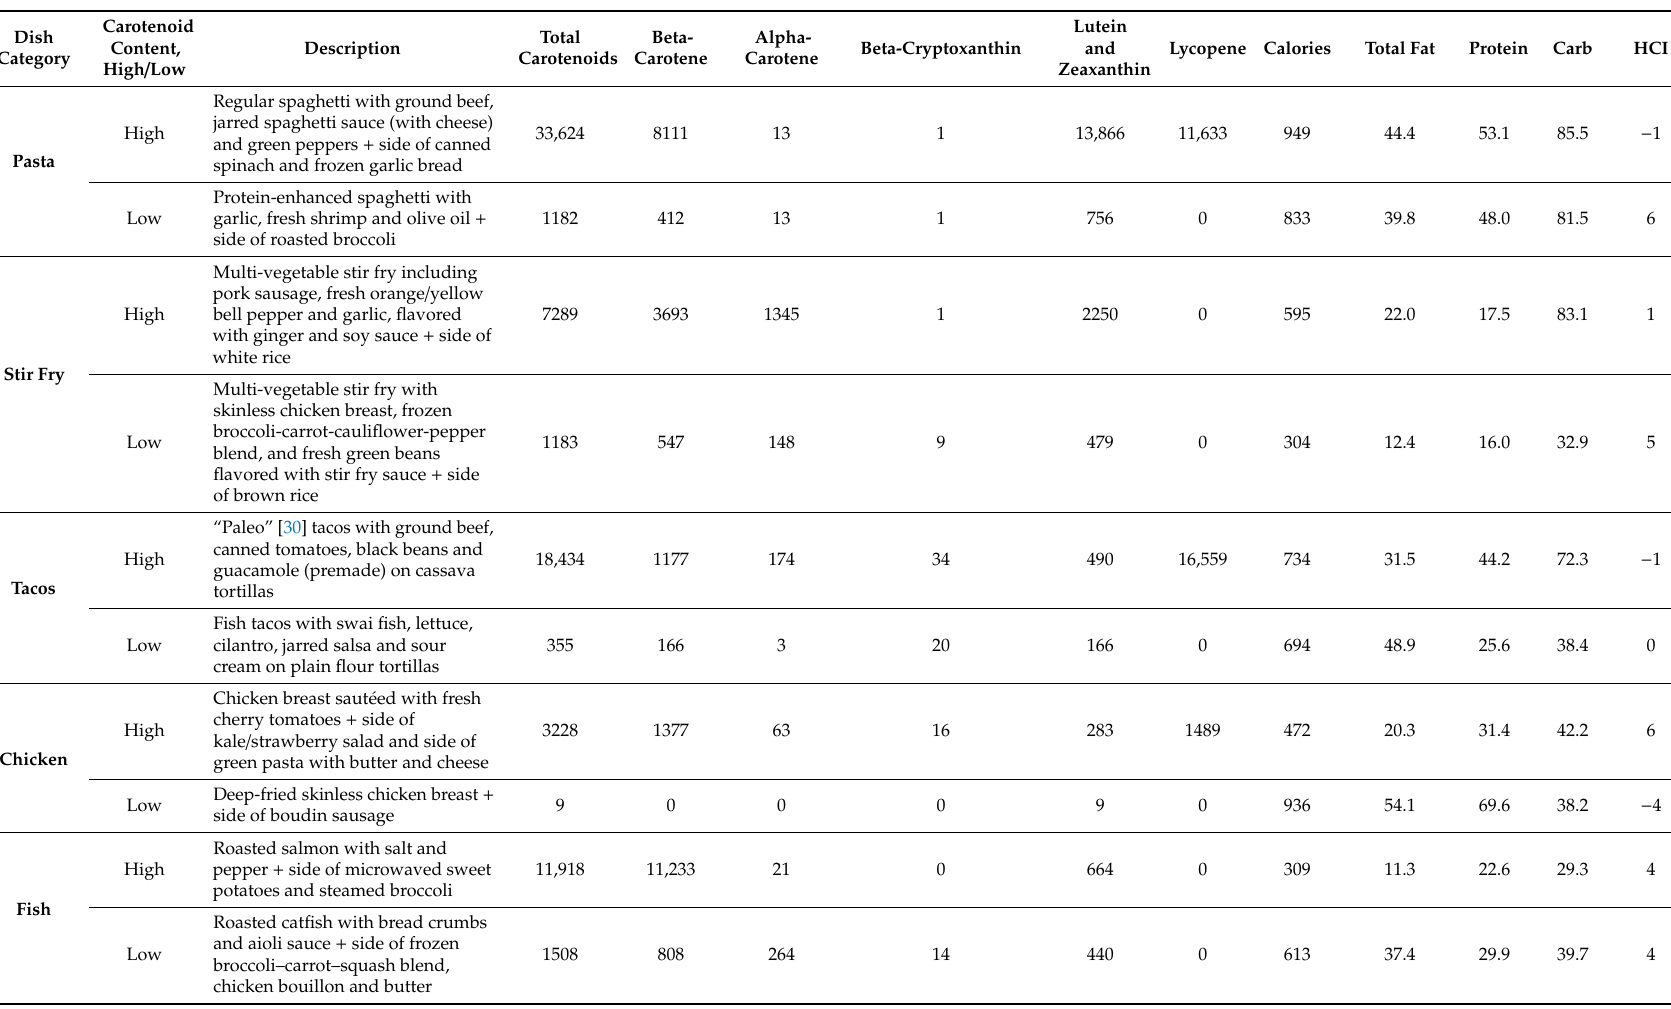
Table 4. Examples of high and low carotenoid content (mcg / serving) meals across categories of prepared dishes, macronutrients (g) and observed Healthy Cooking Index Score